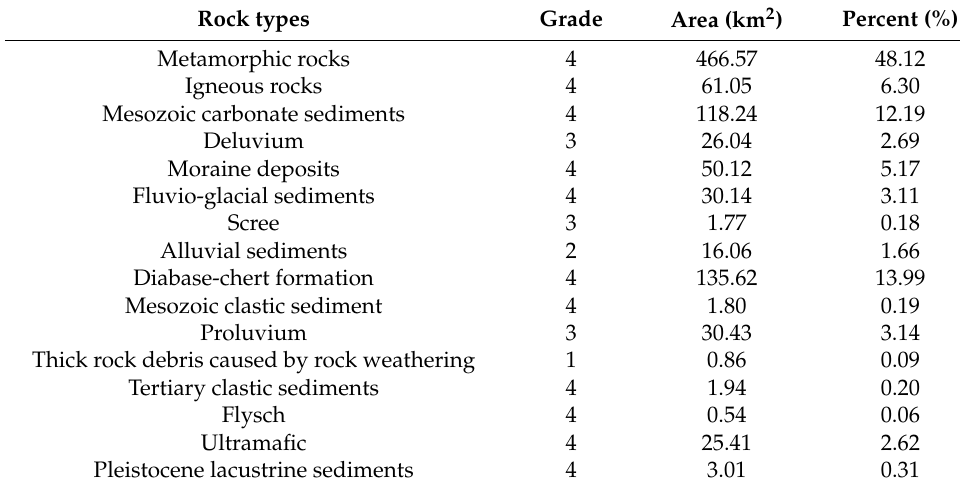
Table 11. Assessment of lithological conditions.